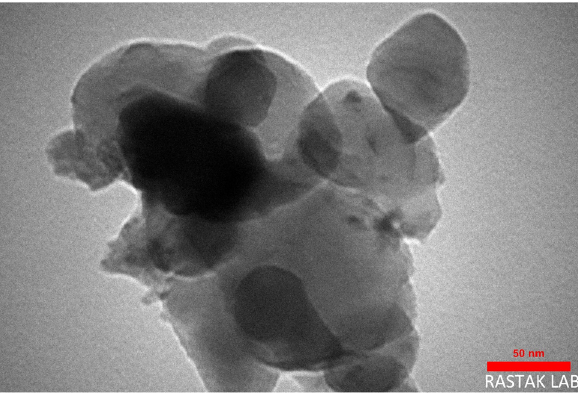
Figure 3: TEM images of